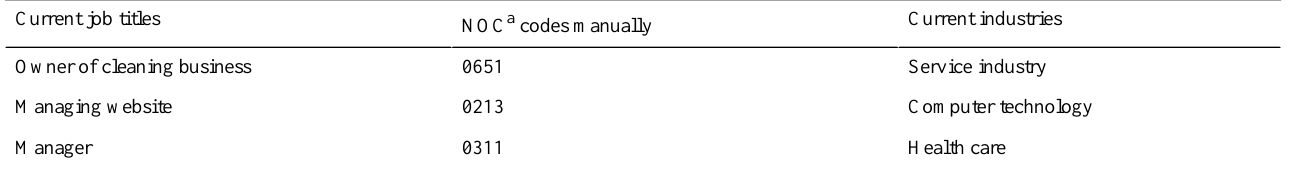
Table 2. Example of the source data sets.